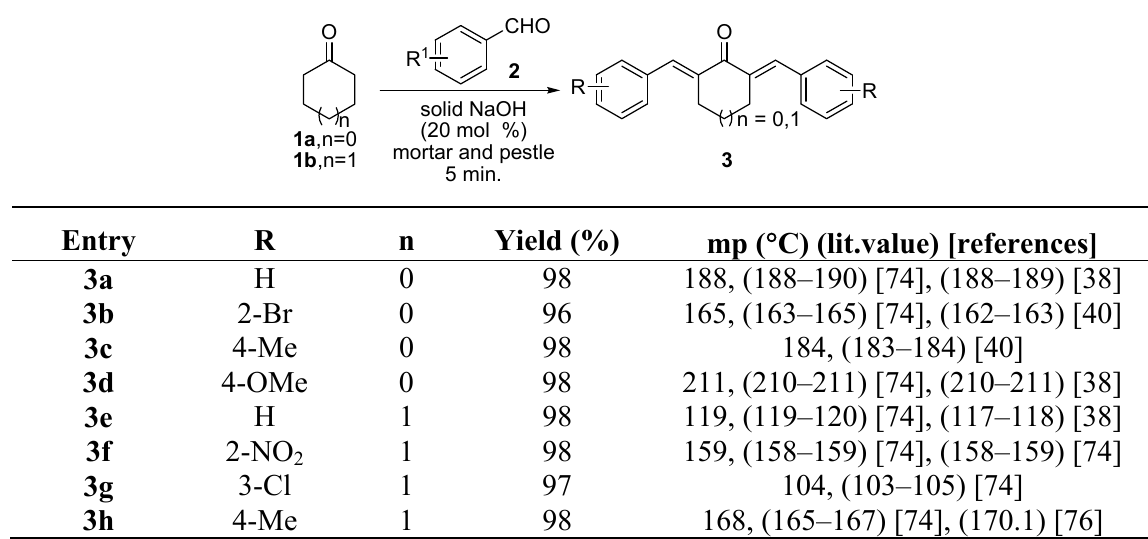
Table 3. The Claisen-Schmidt reaction of 1a–b with 2a–h in presence of solid NaOH (20 mol%) by grinding in a mortar and pestle for 5